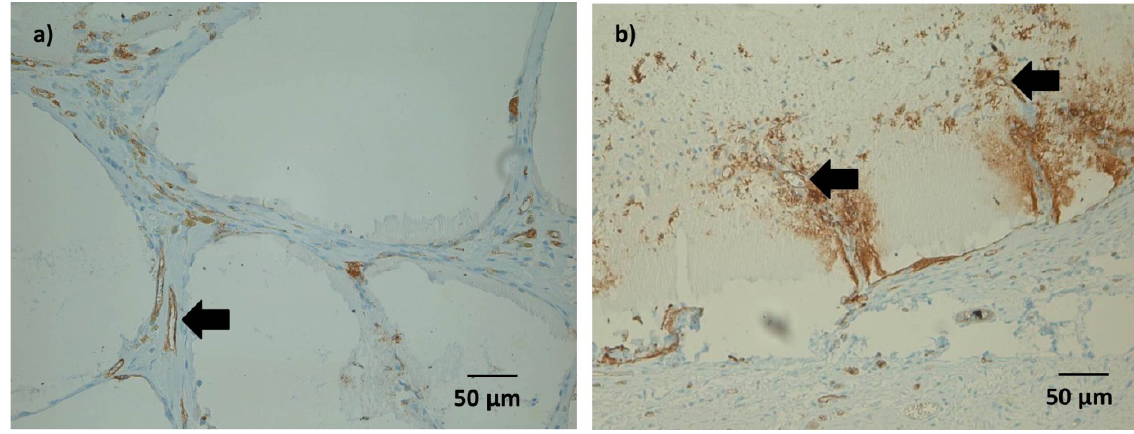
Figure 8. Lectin staining after four weeks (ADA-GEL-nBG group), 20×; ( a ) ED1 positive cells forming tubular structures were common in the connective tissue between the microcapsules (arrow); ( b ) formation of lectin positive tubular structures in microcapsules with connective tissue ingrowth